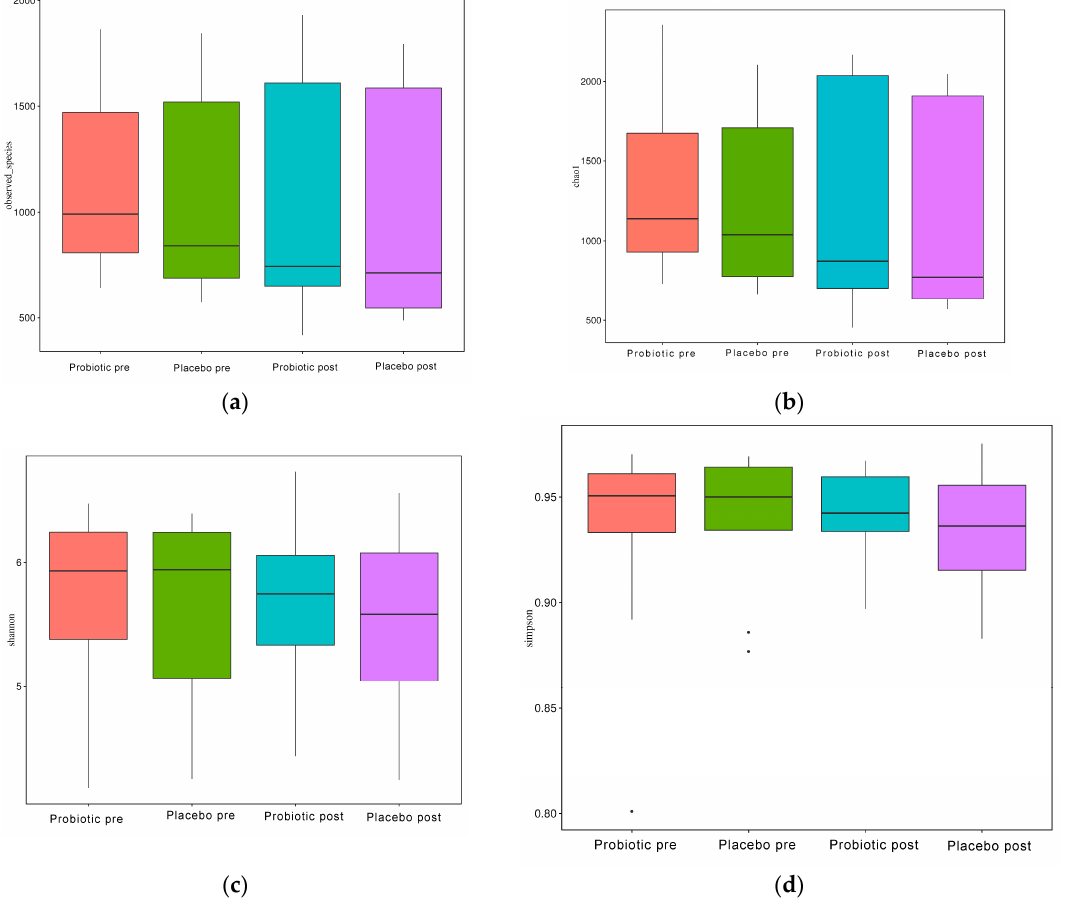
Figure 4. Alpha diversity boxplot index. ( a ) Observed species, ( b ) Chao1, ( c ) Shannon,